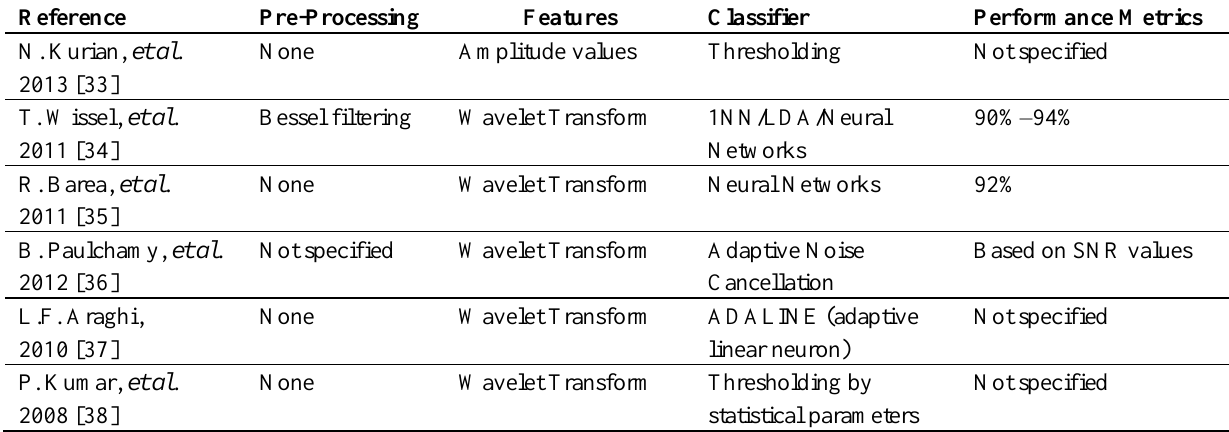
Table 1. Comparison of several reported methods for blinking detection using electrodes as element